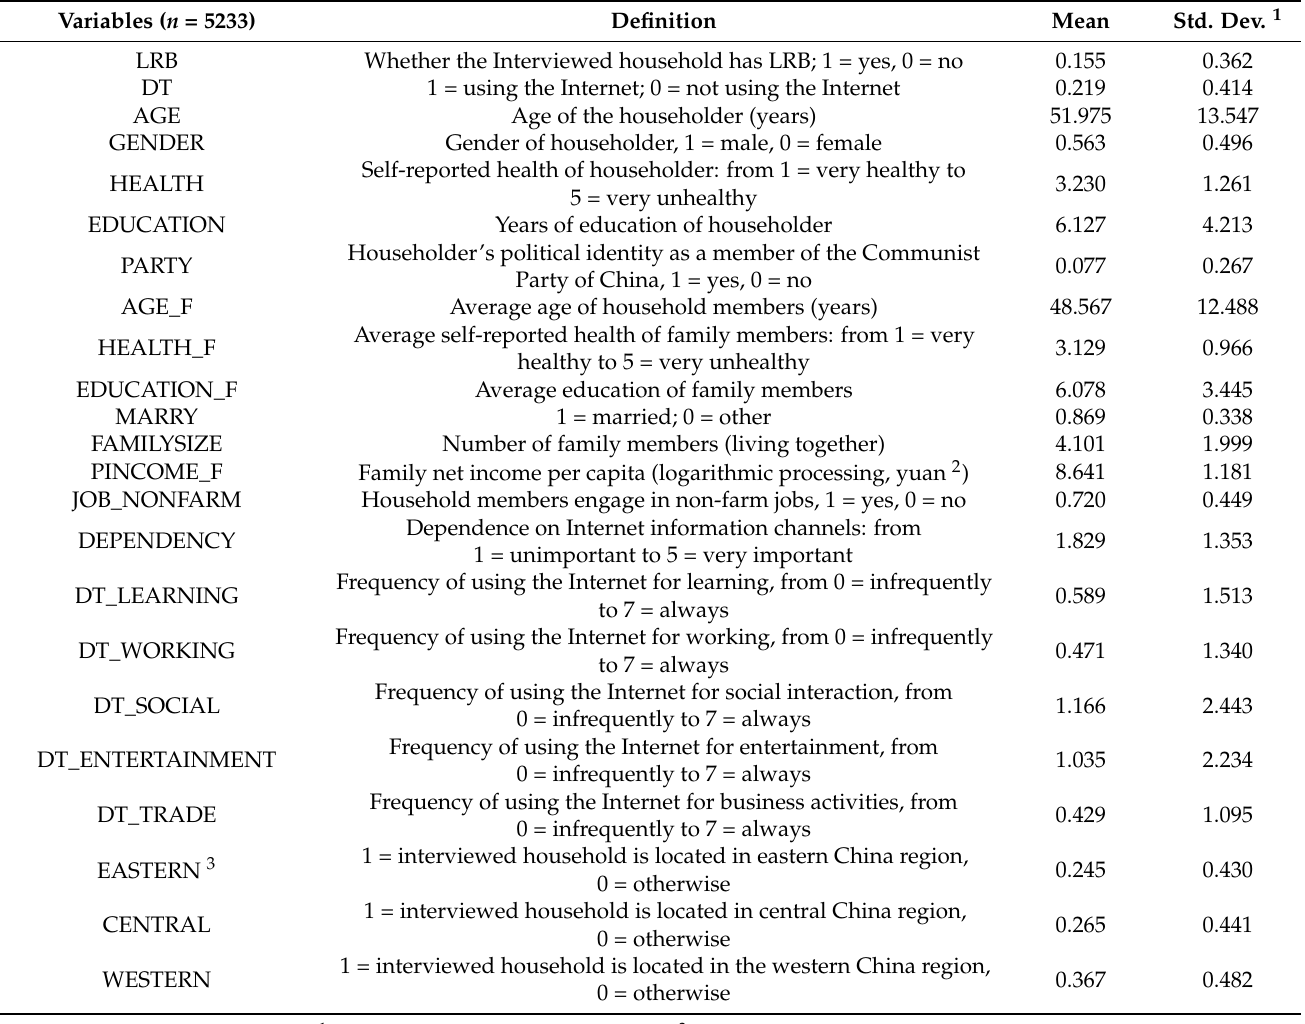
Table 1. Variables, definitions, and descriptive